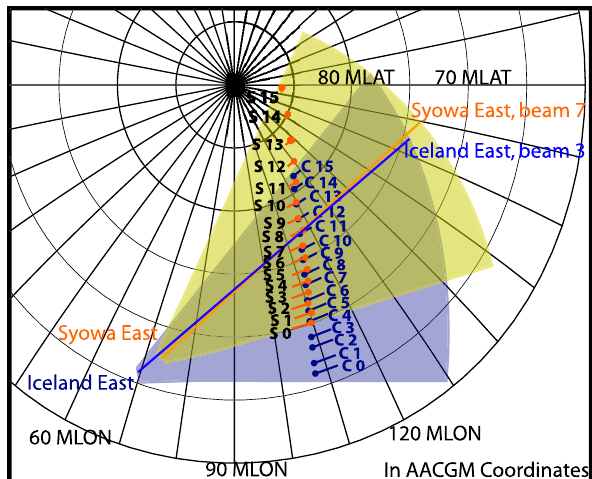
Fig. 1. A map in AACGM of the locations of the field-of-view of the Iceland East radar (blue) and the CUTLASS statistics summary range gates, C0 to C15. In yellow are the conjugately mapped field- of-view of the Syowa East radar and its statistical summary range gates, S0 to